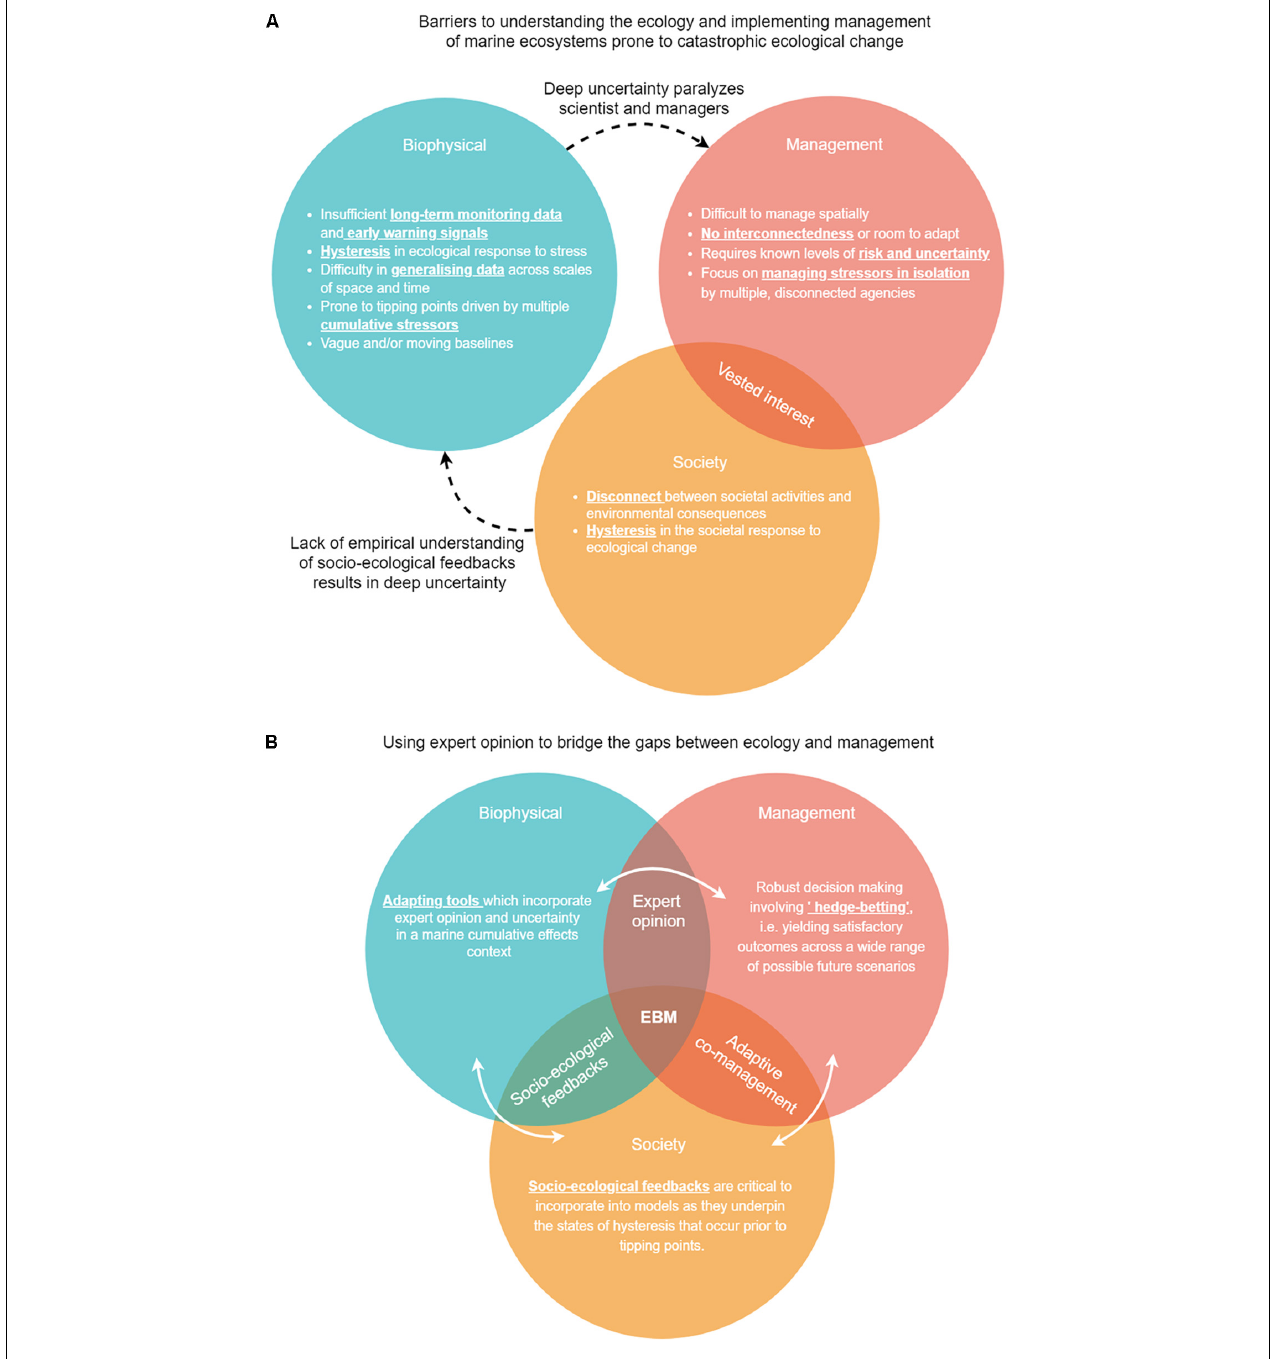
FIGURE 1 | Graphical summary of (A) the current limitations to understanding and managing marine ecosystems in the context of surprise change arising from cumulative effects, and (B) the suggested solutions that use expert opinions to bridge the gaps between ecological knowledge, management, and society to consider multiple plausible futures in robust decision